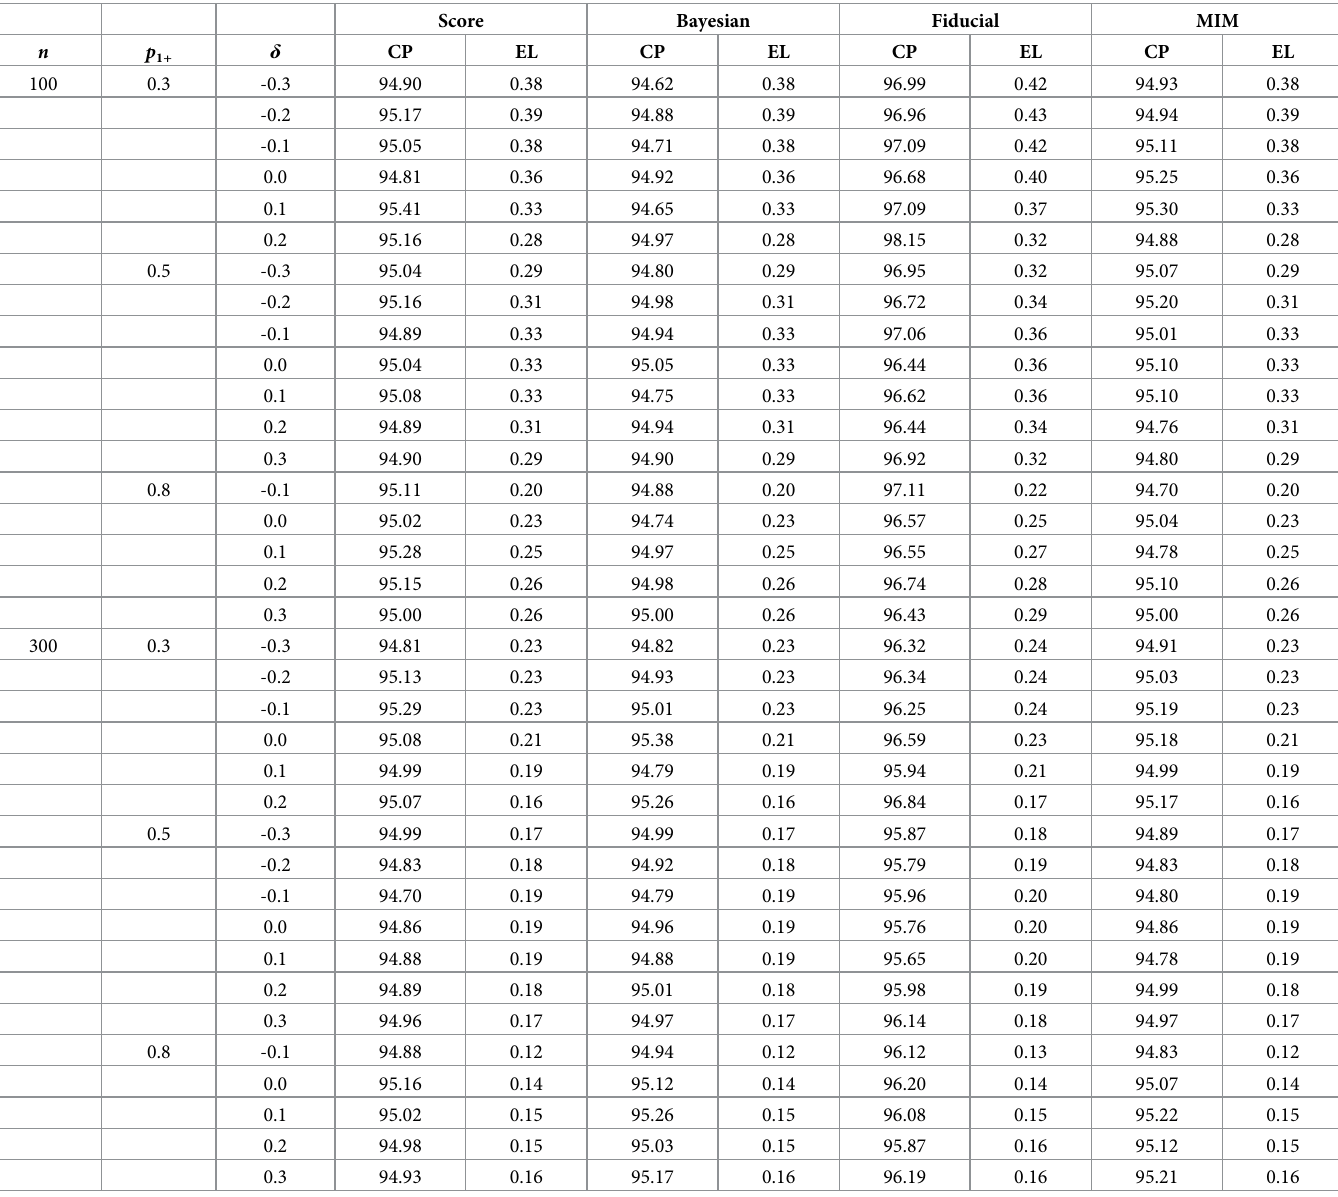
Table 4. The coverage probability (CP) and the expected length (EL) of various 95%